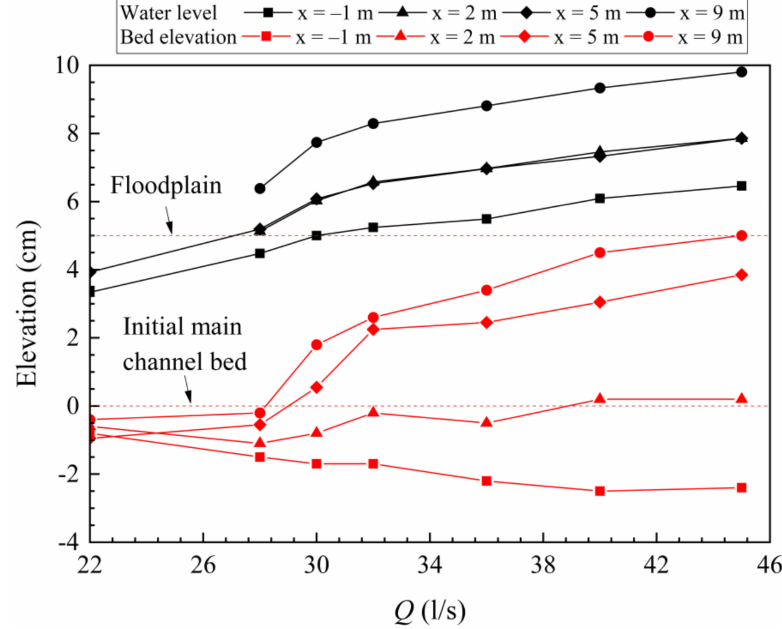
Figure 5. Dependencies of water level and bed elevation in the main channel centerline on the flow discharge at x = − 1 m, x = 2 m, x = 5 m and x = 9 m.